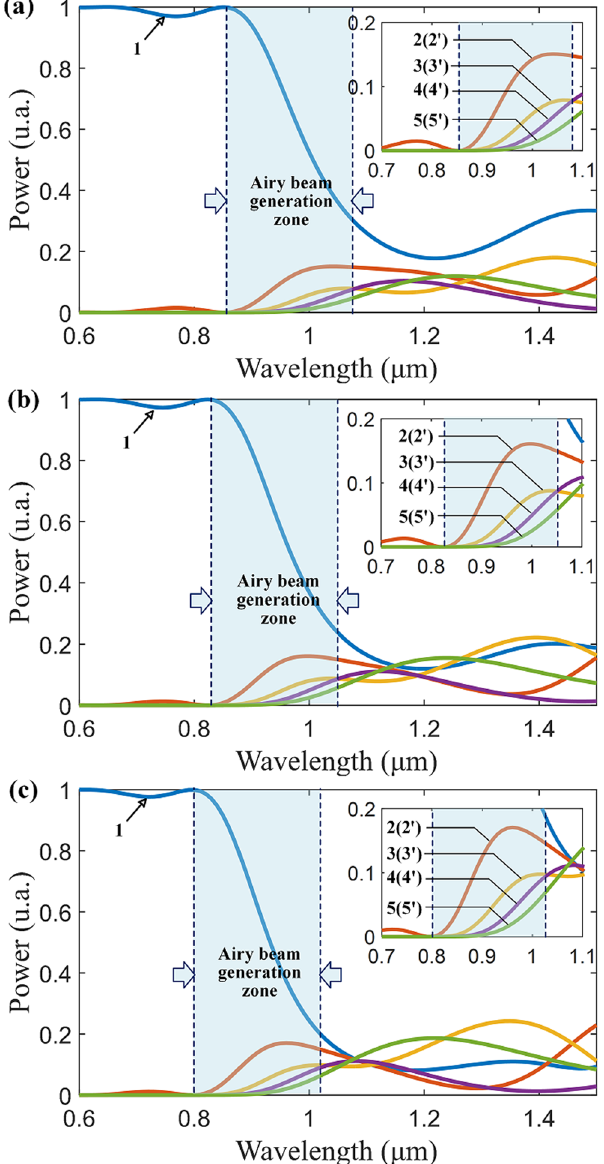
Figure 8. Wavelength response of Airy fiber bent along the X1-axis. ( a ) Positively bending R b = 0.3 m. ( b ) No bending. ( c ) Negatively bending R b = − 0.3